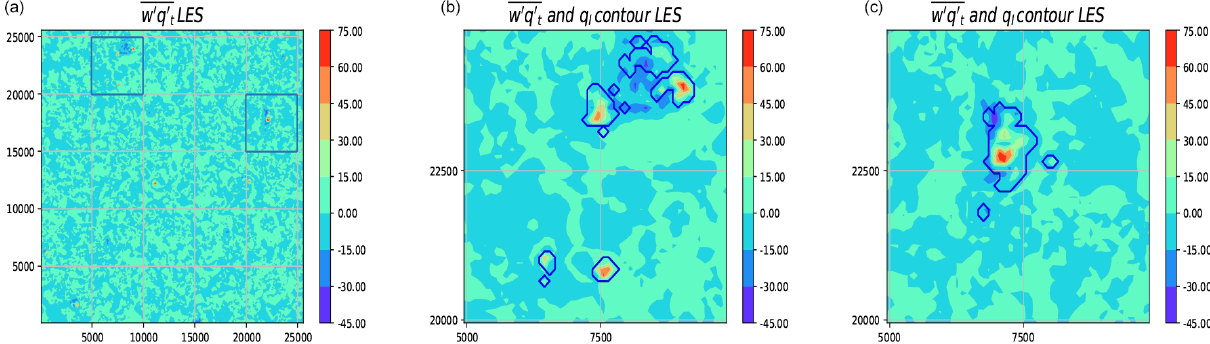
Figure C3. ARM case, ninth simulation hour, cross section of the kinematic turbulent moisture transport at 2310m height (with q t in gkg − 1 ). Blue and yellow/red colours refer to downward and upward transport, respectively. The x and y axes number the LES grid points (with the LES resolution of 100m; the grey grid lines illustrate the size of a HARMONIE-AROME grid box). Panel (a) presents the full LES domain, whereas panels (b) and (c) show, respectively, the left and right subdomains as shown by the blue squares in panel (a) . The blue line defines the cloudy border, i.e. q l =